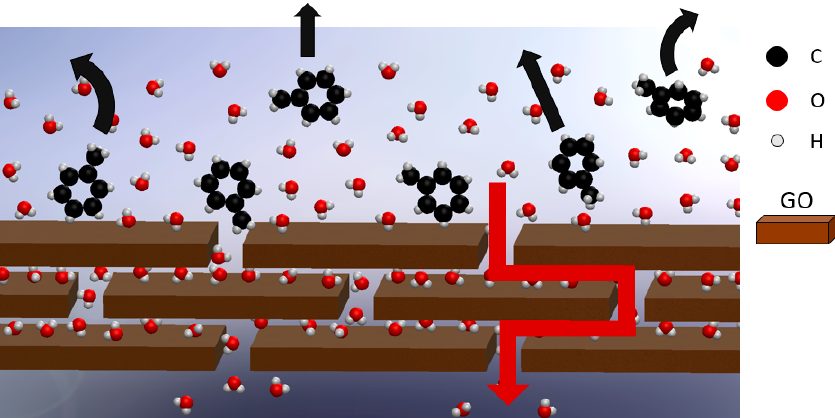
Figure 1. Working principle of graphene oxide (GO) membranes. Here is a sketch of the stacked GO structure, in which water molecules are free to cross the membrane (red arrow) while toluene molecules are rejected (black arrows).